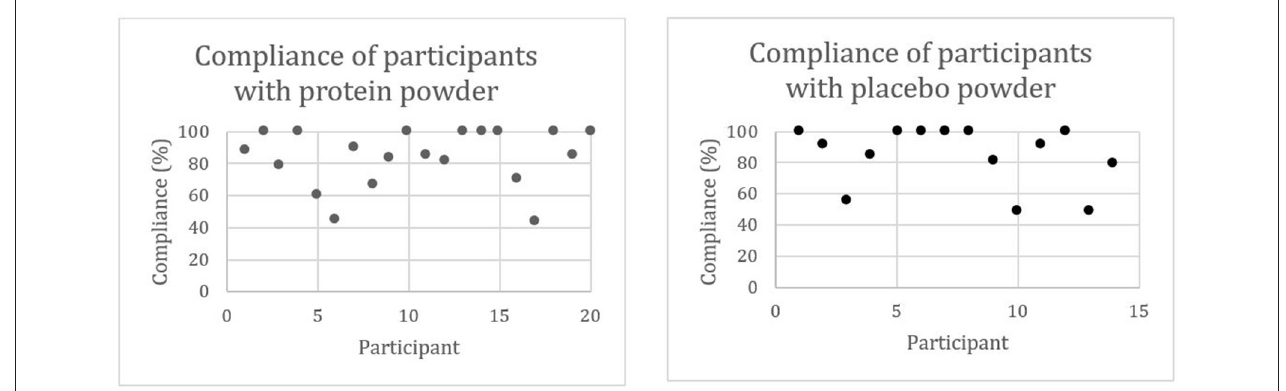
FIGURE 3 | Compliance (%) of community-dwelling (pre)sarcopenic older adults with protein ( n = 20) or placebo ( n = 15) powder